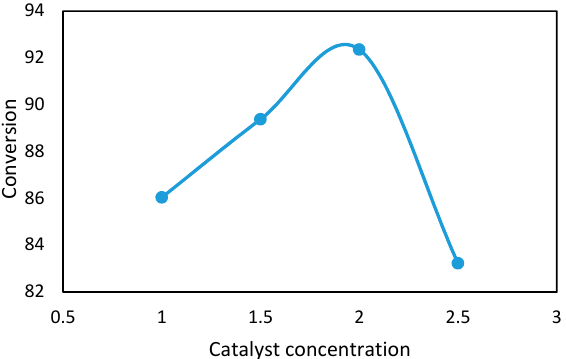
Figure 5. Effect of catalyst concentration on biodiesel production (t = 20 min, T = 140 °C, methanol/oil molar ratio = 10:1).